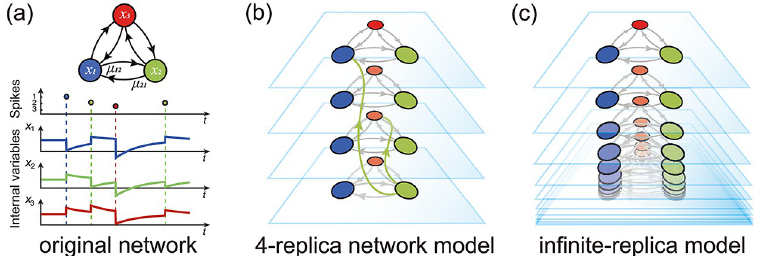
Fig 1. RMF models. Panel (a) shows the original networks of K = 3 neurons. Panel (b) represents the finite-replica model with r = 4 replicas. When a neuron spikes (e.g., green neuron), it interacts with downstream neurons sampled uniformly at random across replicas. Panel (c) shows schematically that the RMF models are obtained in the limit of an infinite number of replicas and represent infinite-size physical models supporting RMF dynamics. This figure is reproduced from [52] with